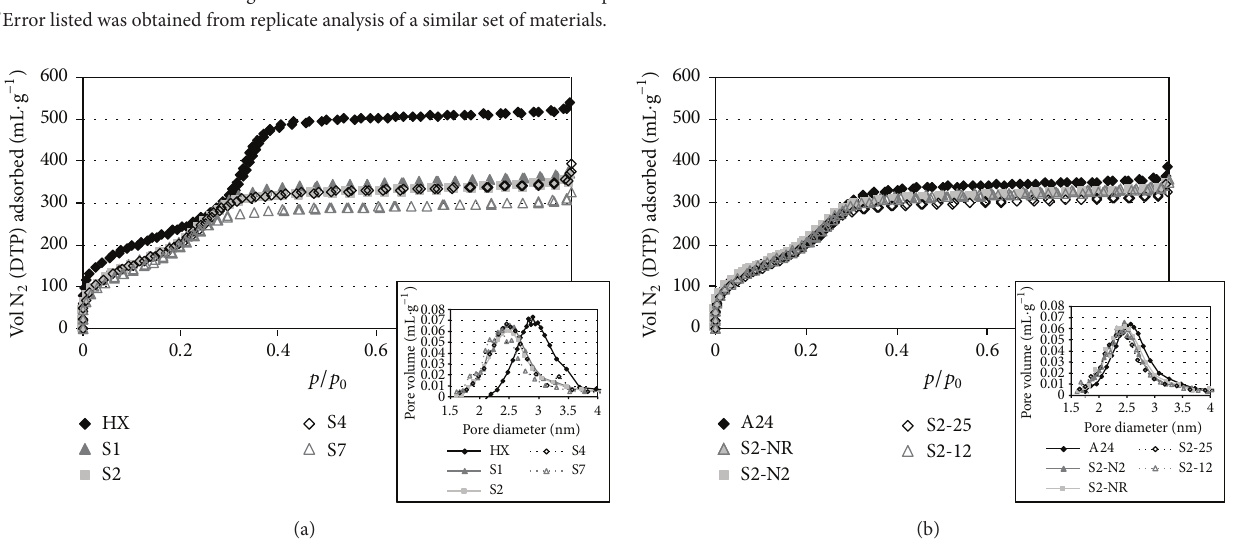
Figure 2: N 2 a/d 77K isotherms with inset BJH pore size distributions obtained for (a) HX, S1, S2, S4, and S7 and (b) A24, S2-NR, S2-N2, S2-25, and S2-12.